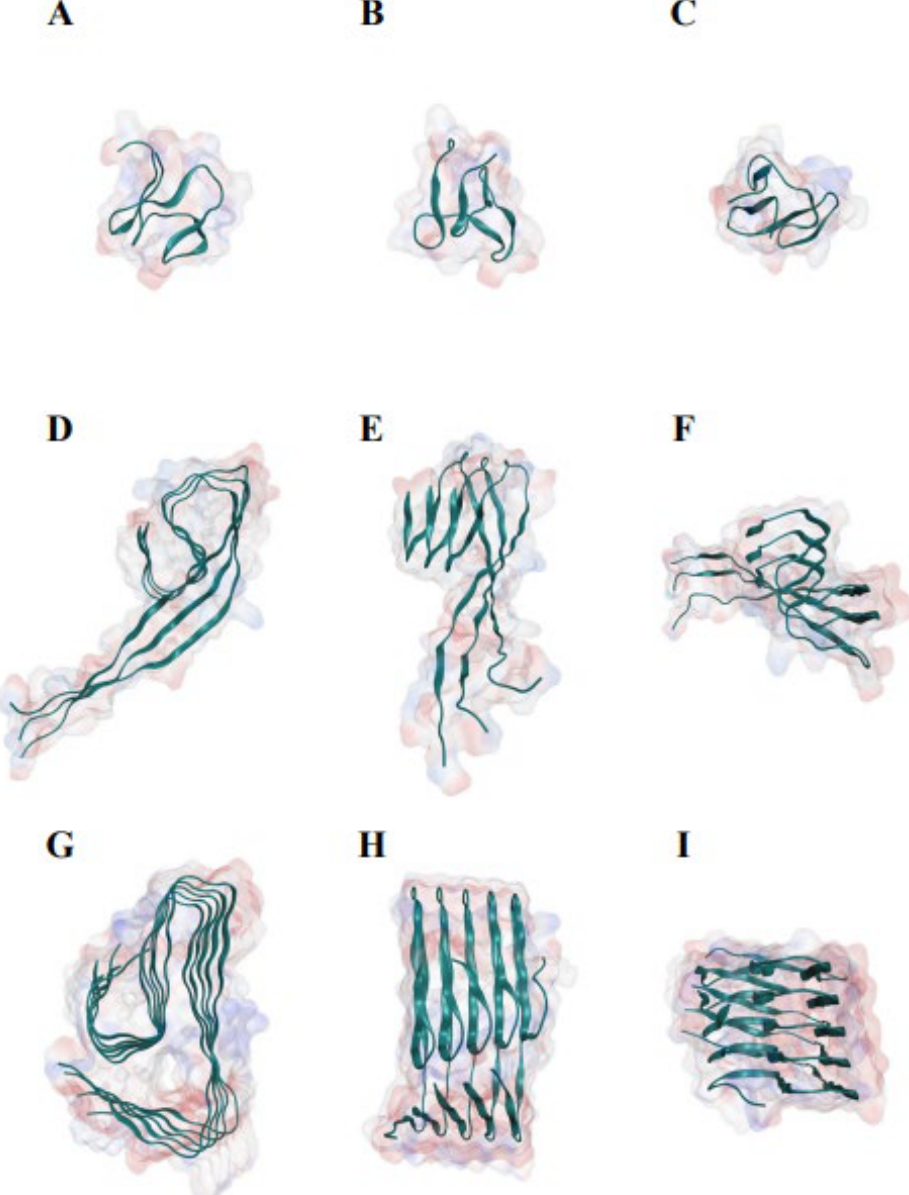
Figure 1. Molecular dynamics study of the structures of Aβ 42 monomer, trimer, and pentamer in 0.1 M sodium chloride solution, demonstrating the association of Aβ 42 polymerization with β -sheet conformation. ( A ) The front view of Aβ 42 monomer. ( B ) The side view of Aβ 42 monomer. ( C ) The top view of Aβ 42 monomer. ( D ) The front view of Aβ 42 trimer. ( E ) The side view of Aβ 42 trimer. ( F ) The top view of Aβ 42 trimer. ( G ) Th e front view of Aβ 42 pentamer. ( H ) The side view of Aβ 42 pen- tamer. ( I ) The top view of Aβ 42 pentamer. The monomer, trimer, and pentamer of Aβ 42 were mod- eled using the near atomic structure (PDB ID #5oqv) as starting conformations. Each analysis sim- ulated 500-ns interaction and movements, with a data size of roughly 160 Gb.